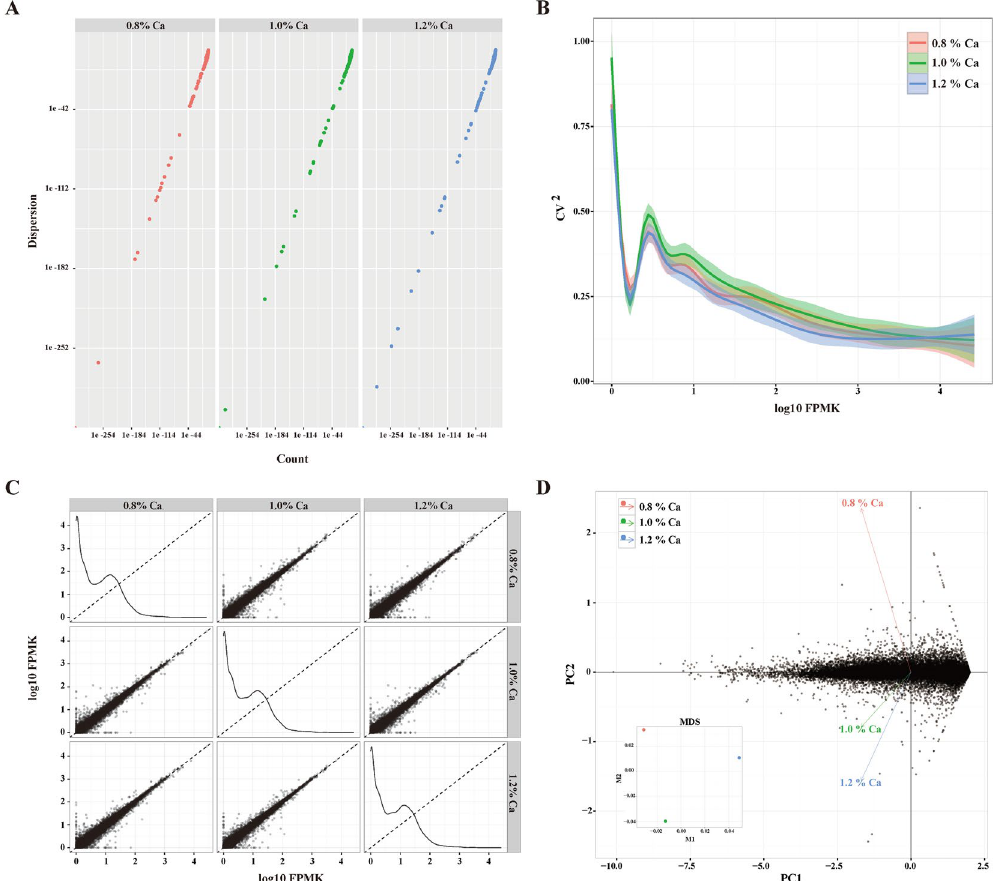
Figure 1. Comparative analysis of RNA-seq data from the kidney of broiler chickens fed diets containing 0.8, 1.0, and 1.2% Ca (three samples each). ( A ) Count versus dispersion plot by condition for all genes. ( B ) The squared coefficient of variation allows the visualization of cross-replicate variability between conditions, and can be a useful metric for determining data quality at the gene level. ( C ) Scatterplots to identify global changes and trends in gene expression between pairs of conditions. ( D ) PCA and MDS plots for gene-level